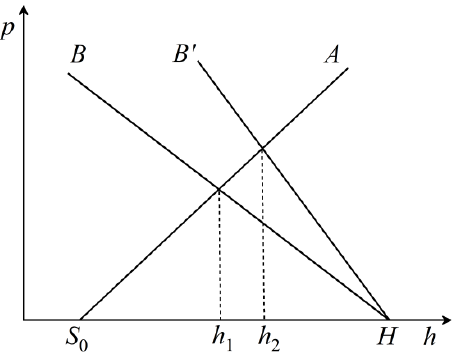
Figure 6. Schematic diagram of tension adjustment.